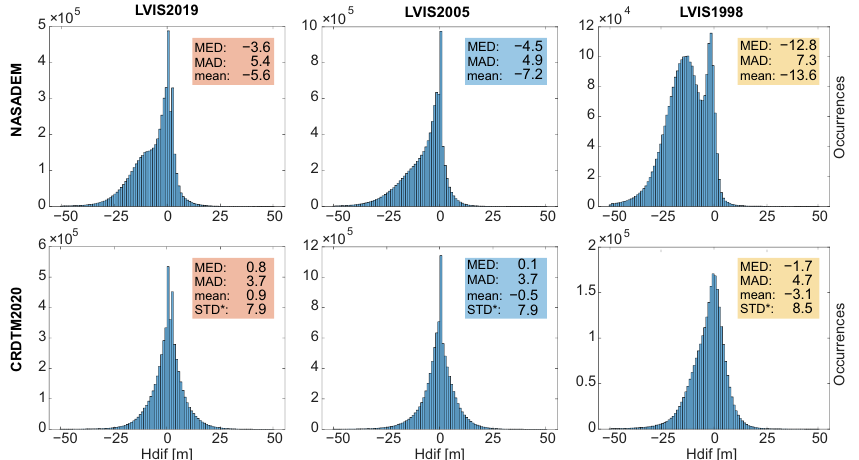
Figure 14. Histogram of the differences between NASADEM (first row) and CRDTM2020 (second row) from three LVIS surveys from 2019, 2005, and 1998. Note that the LVIS2005 dataset was used for the determination of coefficient a in the vegetation bias correction model, while the LVIS2019 and the LVIS1998 datasets were used only for validation. The statistics is provided in terms of the Median Difference (MED), Median Absolute Difference (MAD), mean difference, and Standard Deviation (STD*) for differences without outliers larger than ±